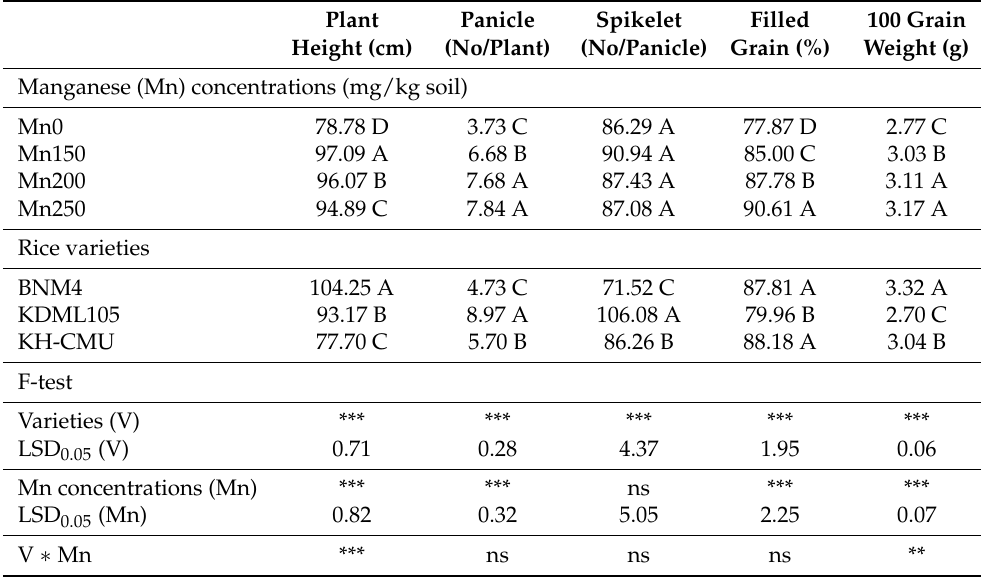
Figure 4. Effects of different manganese concentrations on the grain yield of different Thai fragrant rice varieties. Each column represents the mean of three data points ± standard errors ( n = 3). Means sharing a common letter do not differ significantly at p < 0.05. Table 3. Yield components of three rice varieties (i.e., BNM4, KDML105 and KH-CMU) grown in soil with four rates of Mn concentration (0, 150, 200 and 250 mg/kg soil).